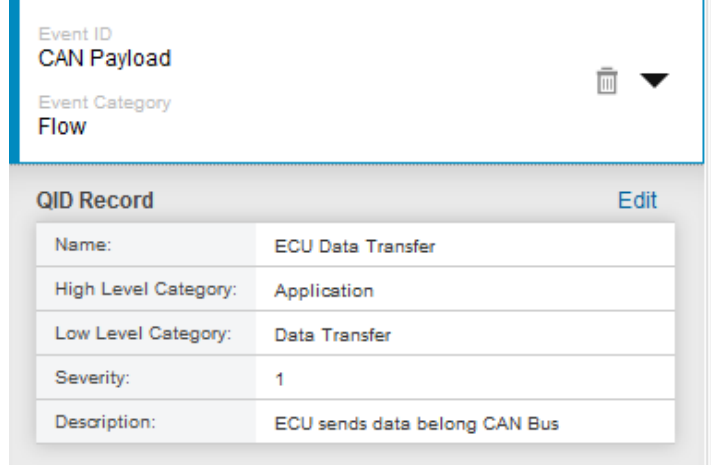
Figure 4. Event ID and event category used to create a new QID named ECU data transfer.